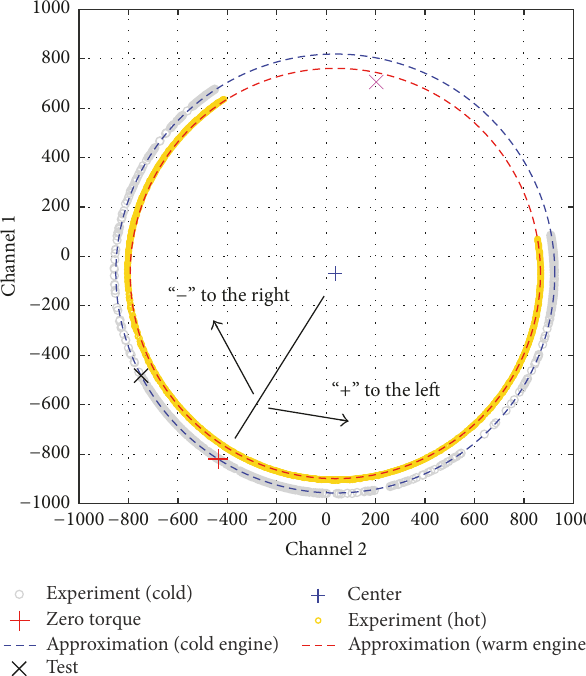
Figure 1: Protocol interpretation of the steering column torque